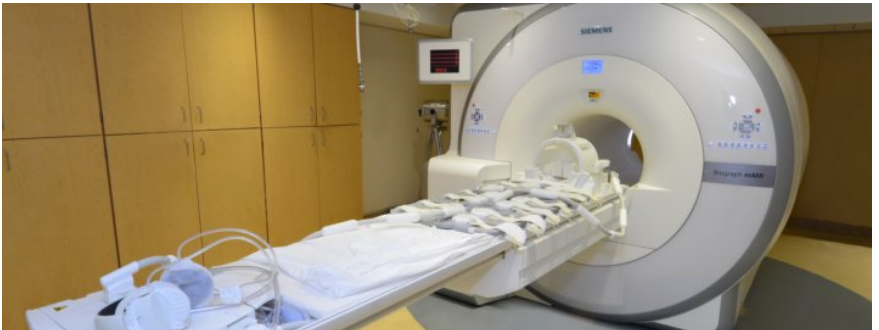
Figure 6. Positron Emission Tomography and Magnetic Resonance Imaging scanner; photo